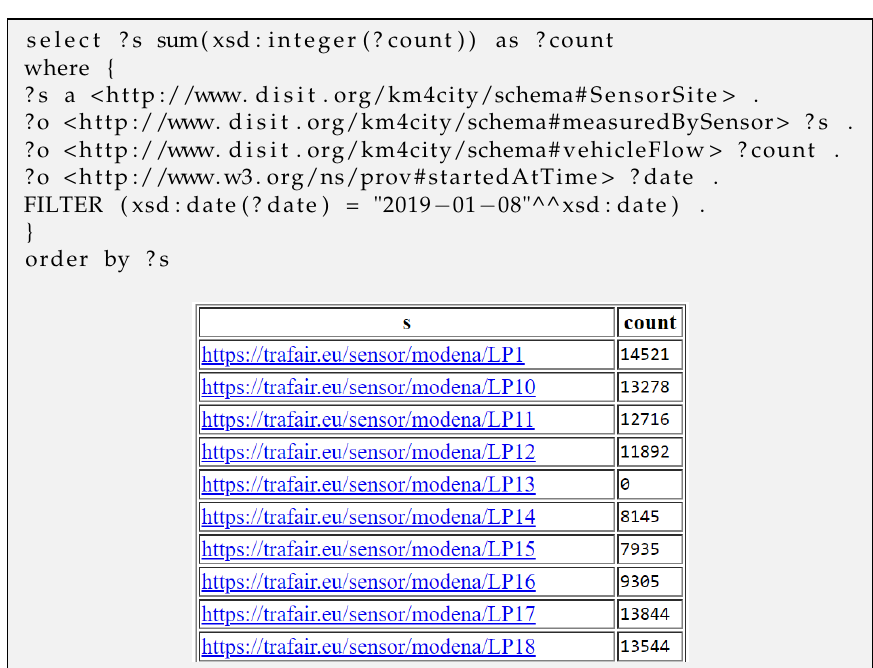
Figure A2. SPARQL query showing the number of sensors in Modena and in Zaragoza.